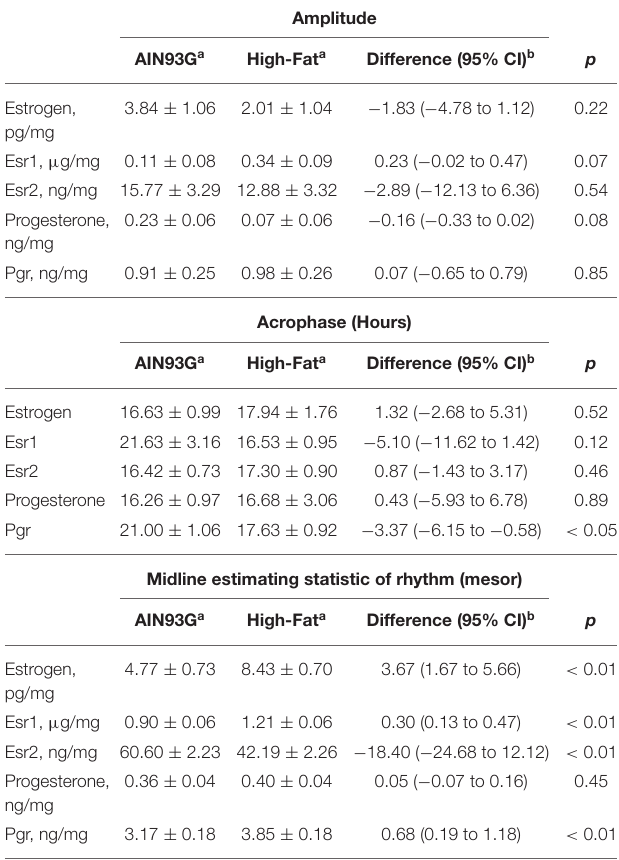
diet groups. TABLE 5 | Concentrations of estrogen, progesterone, and their receptors in mammary glands from pubertal mice fed AIN93G or high-fat diet. AIN93G